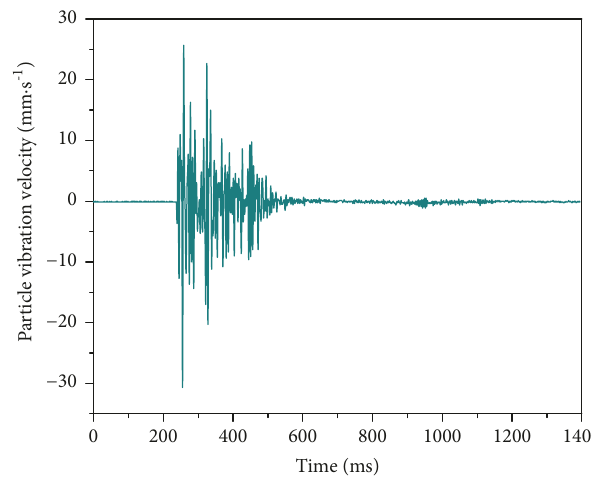
Figure 7: Particle vibration velocity-time curve for sonic wave monitoring hole No.